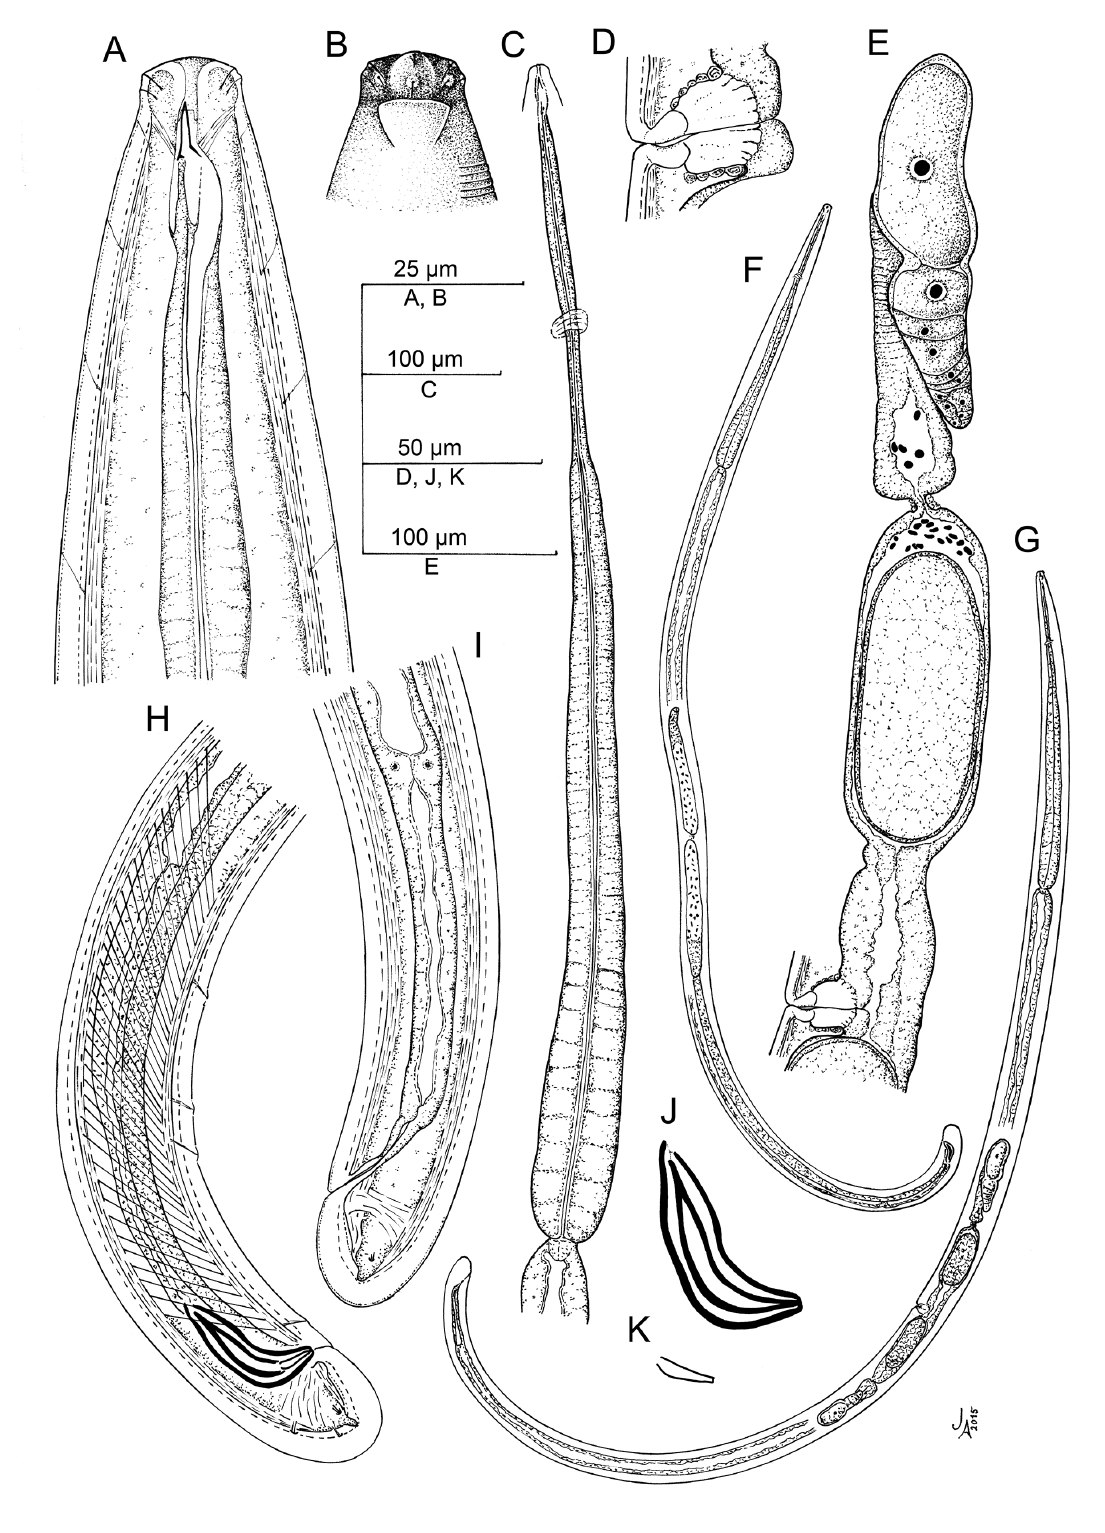
Fig. 7. Sectonema vietnamense sp. nov. (Line). A . Anterior region in median, lateral view. B . Lip region in surface, lateral view. C . Neck region. D . Vagina. E . ♀, anterior genital branch. F . ♂, entire. G . ♀, entire. H . ♂, posterior body region. I . ♀, posterior body region. J . Spicule. K . Lateral guiding